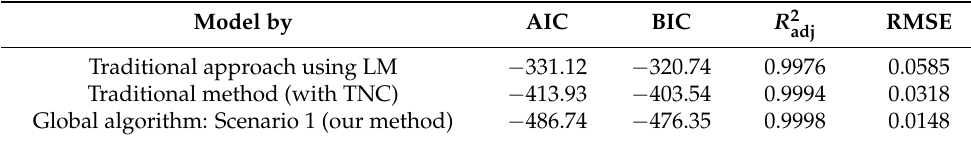
Table 2. Summary of the models with their quality measures. Model by AIC Traditional approach using